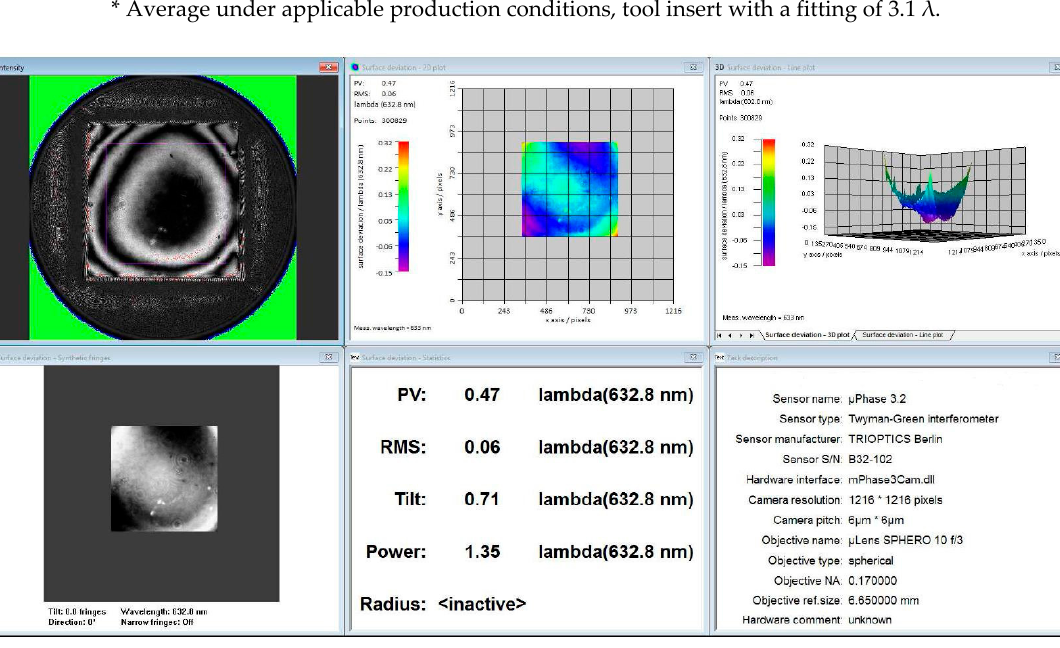
Figure 1. Wavefront topography measurement of an electroplated cast